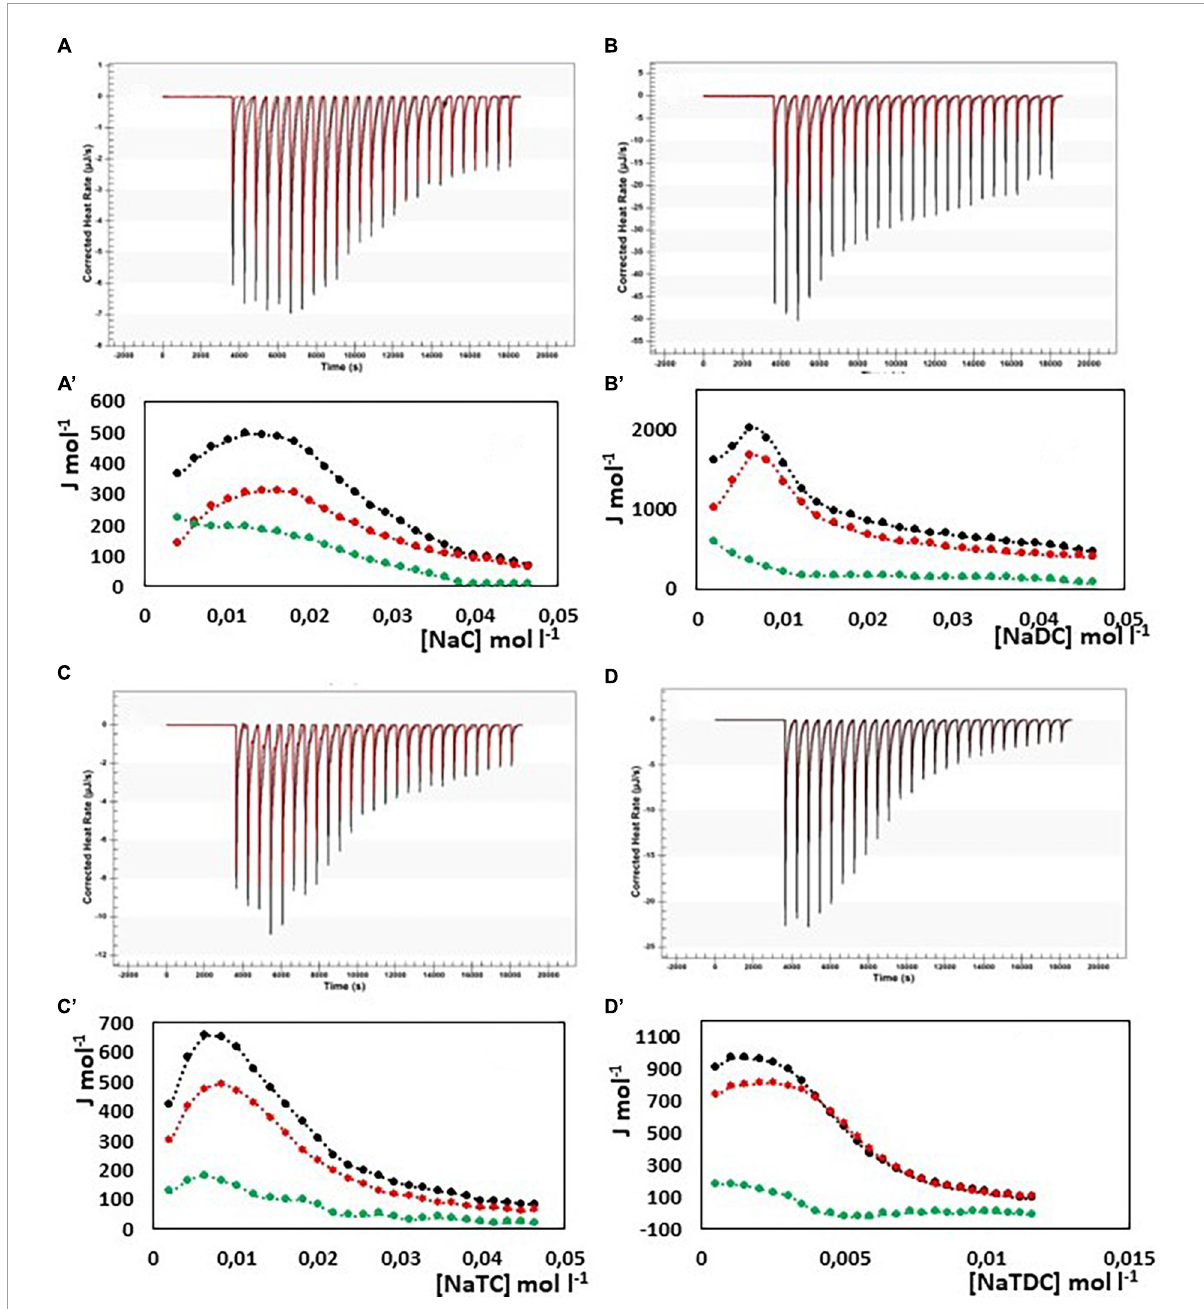
FIGURE4 Heat rate ( µ J s − 1 ) vs. time profiles obtained from 25 injection each of 10 µ L into a 960 µ L reaction cell filled with an alginate solution 1 g L − 1 (black) compared with the dilution of bile salt (red) in the same conditions, and (specified by a single quote mark) the dependence of the enthalpy change vs. bile salt concentration in the reaction cell for: (A) NaC 200 mM; (B) NaDC 200 mM; (C) NaTC 200 mM; (D) NaTDC 50 mM. Black dots represent the interaction enthalpy between alginate and bile salt, the red dots the dilution enthalpies of bile salt and the green dots their